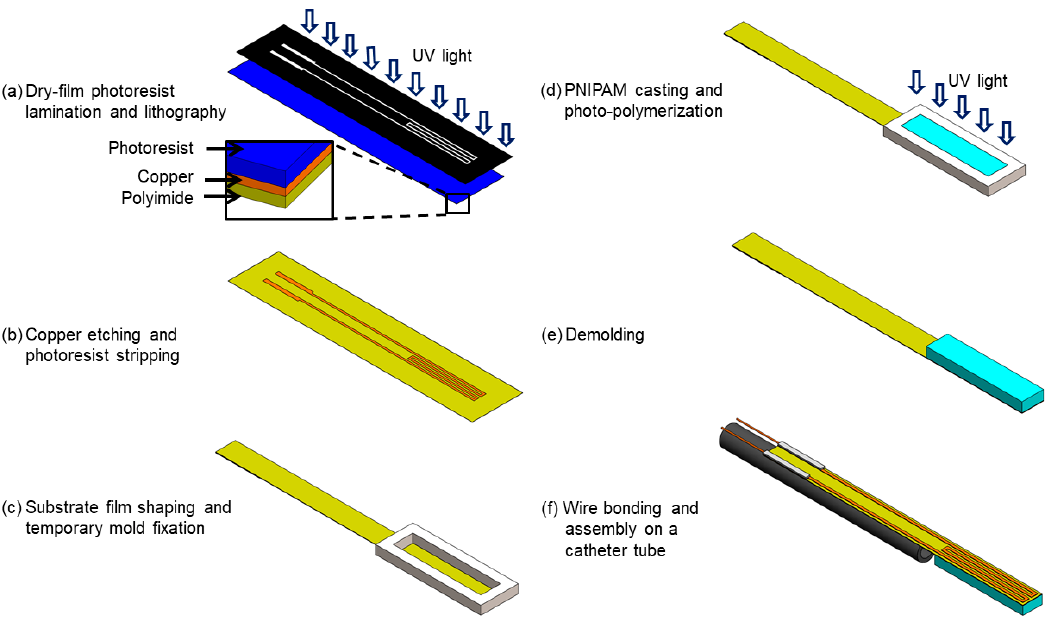
Figure 3. Process steps developed for the fabrication of the active catheter tip device.